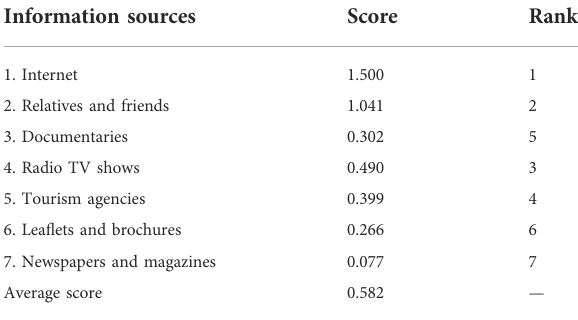
TABLE 11 Scores for information sources used by young tourists to plan their vacation in an ecotourism destination. Information